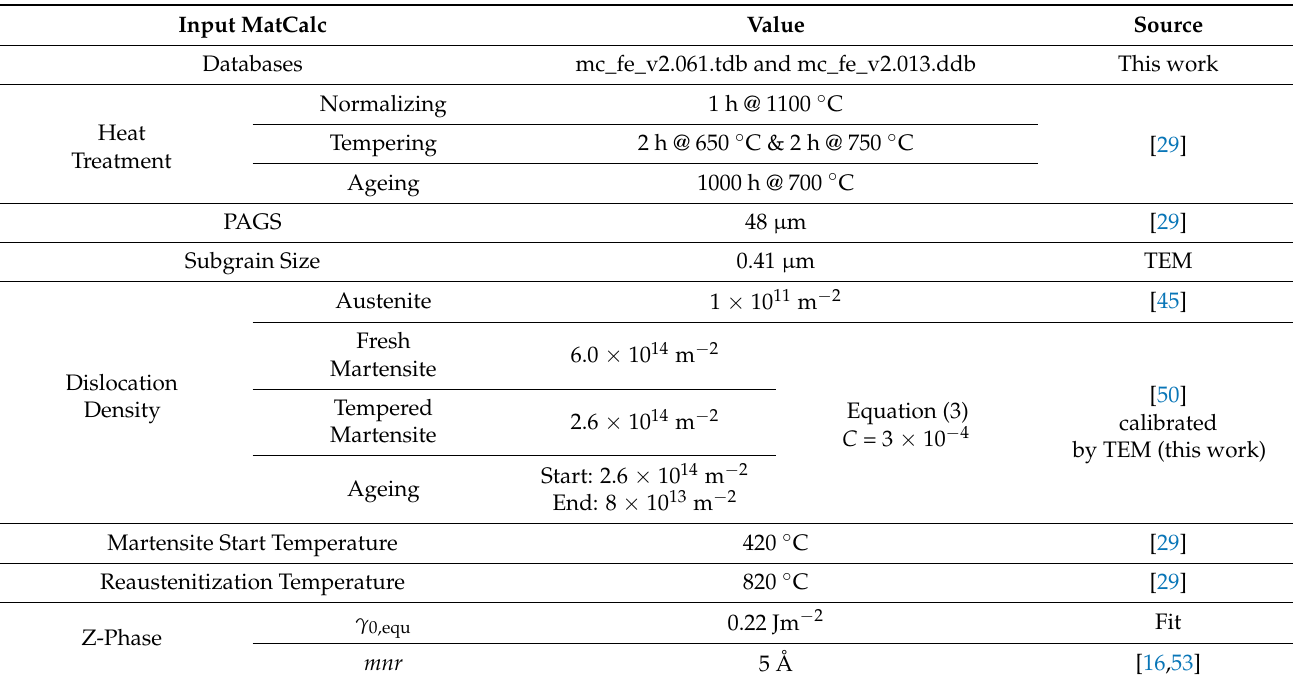
Table 4. Input parameters for MatCalc 6.03 precipitate kinetic simulation of Z6.